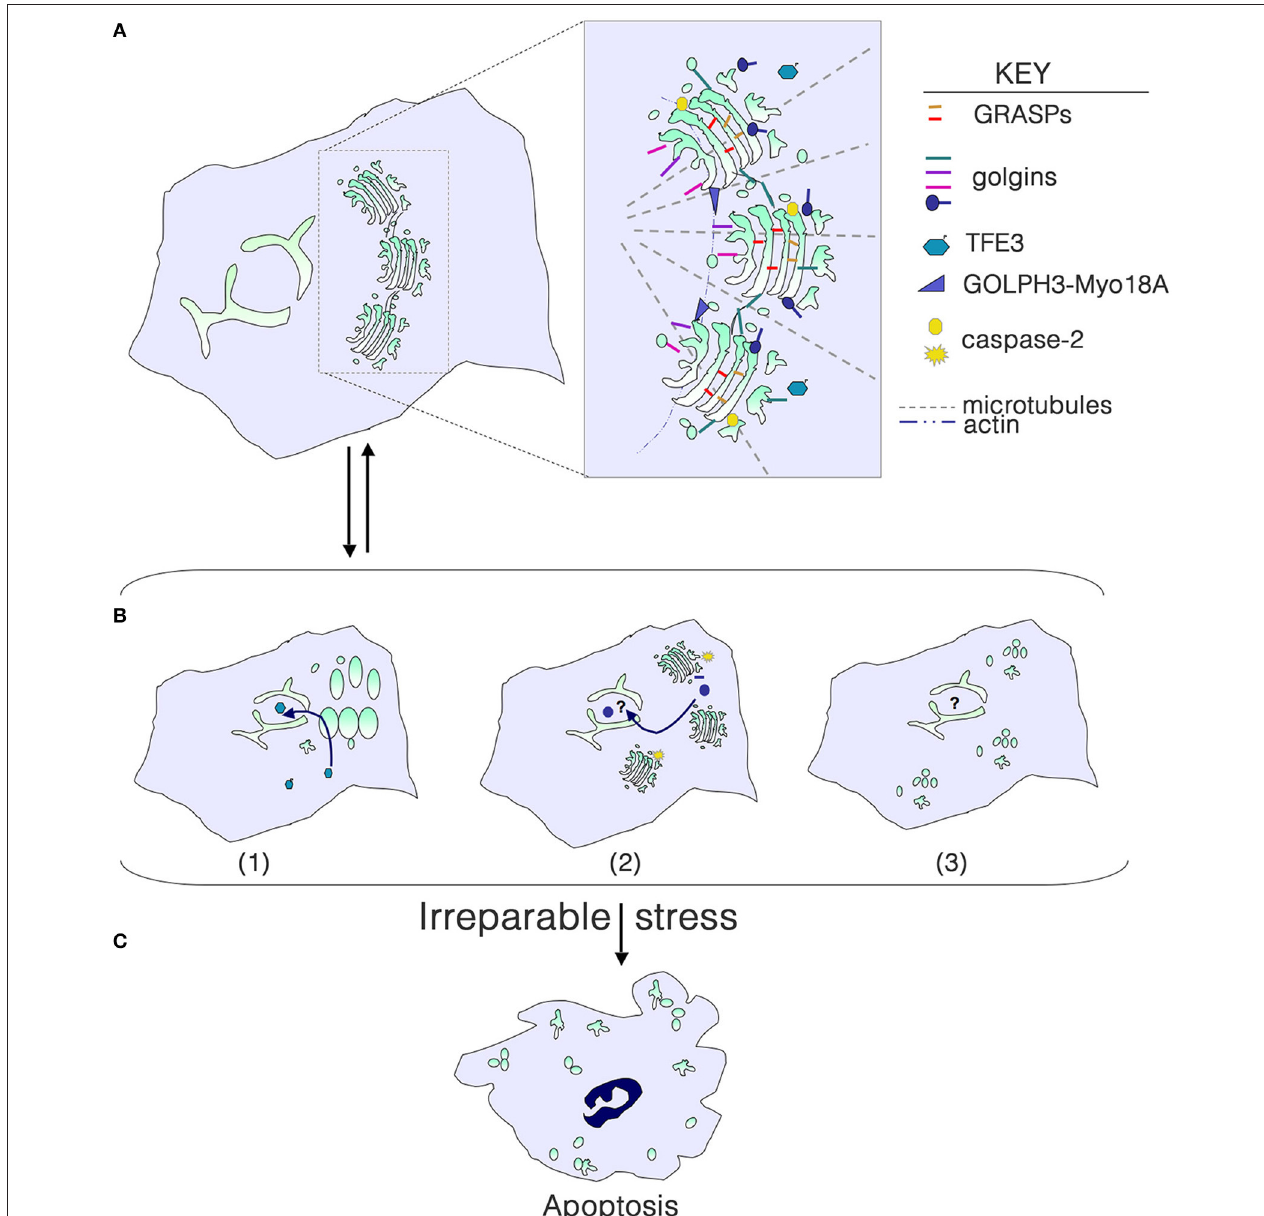
FIGURE 1 | Golgi structure in life, stress and death. (A) Golgi morphology in a typical mammalian cell, with the key structural players shown in the inset. For simplicity, individual golgins and GRASPs are not indicated. (B) Golgi stress due to cargo load or size, ionic imbalance, infection with intracellular pathogens, or perturbation of glycosylation or the cytoskeleton results in structural alterations that can signal to the nucleus to help repair the stress. (1) Dephosphorylation of TFE3 and tranlocation to the nucleus results in transcription of genes with a GASE, including some glycosyltransferases and trafficking components. (2) Activation of local caspase-2 cleaves select golgins, and fragments enter the nucleus to perform an unknown function. (3) Phosphorylation of GRASPs and golgins or their cleavage can result in a more complete disassembly of the Golgi, although the consequences for signaling to the nucleus are unknown. (C) With irreparable stress, the Golgi is completely disassembled as the cell undergoes